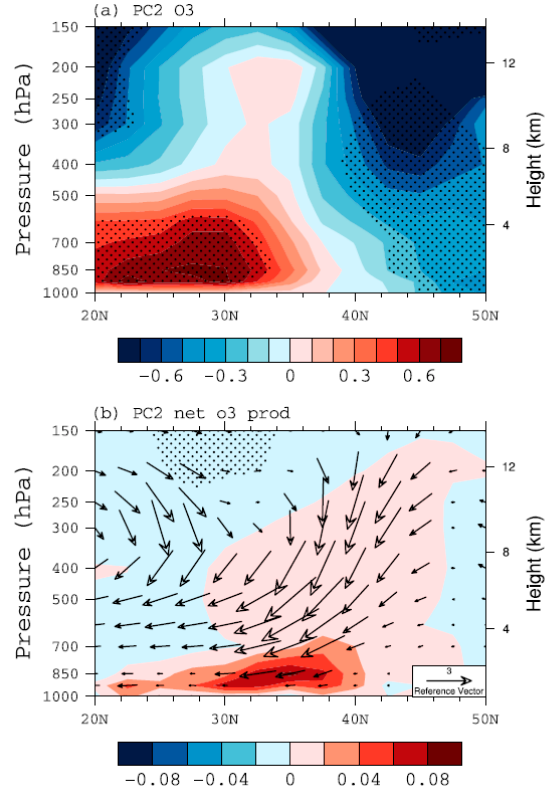
Figure 9. Same as Figure 7, except for PC2 time series and longitude from 110° E to 120° E.